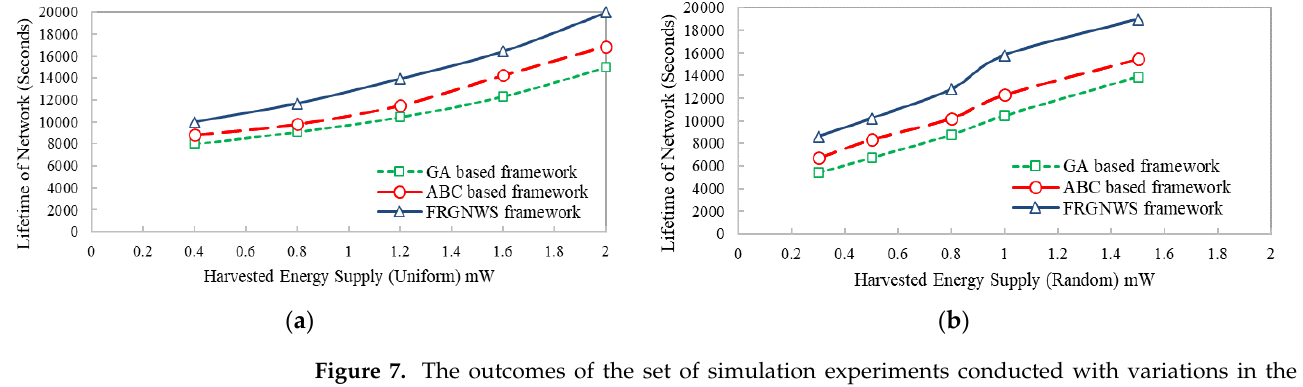
Figure 7. The outcomes of the set of simulation experiments conducted with variations in the harvested energy supply uniformly as well as randomly: ( a ) lifetime of the network with variations in the harvested energy supply (uniformly); ( b ) lifetime of the network with variations in the harvested energy supply (randomly). Tables 11 and 12 are given below.